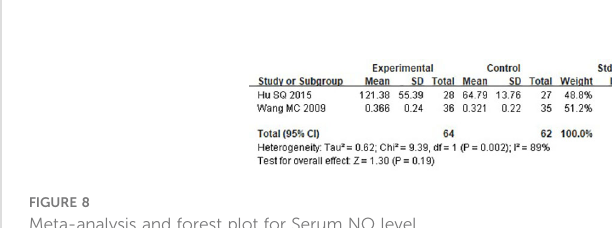
FIGURE 8 Meta-analysis and forest plot for Serum NO level.